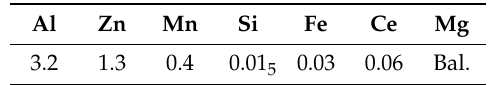
Figure 2. Geometry of samples for tensile tests. Table 1. Chemical composition of the sheet (in wt.%).